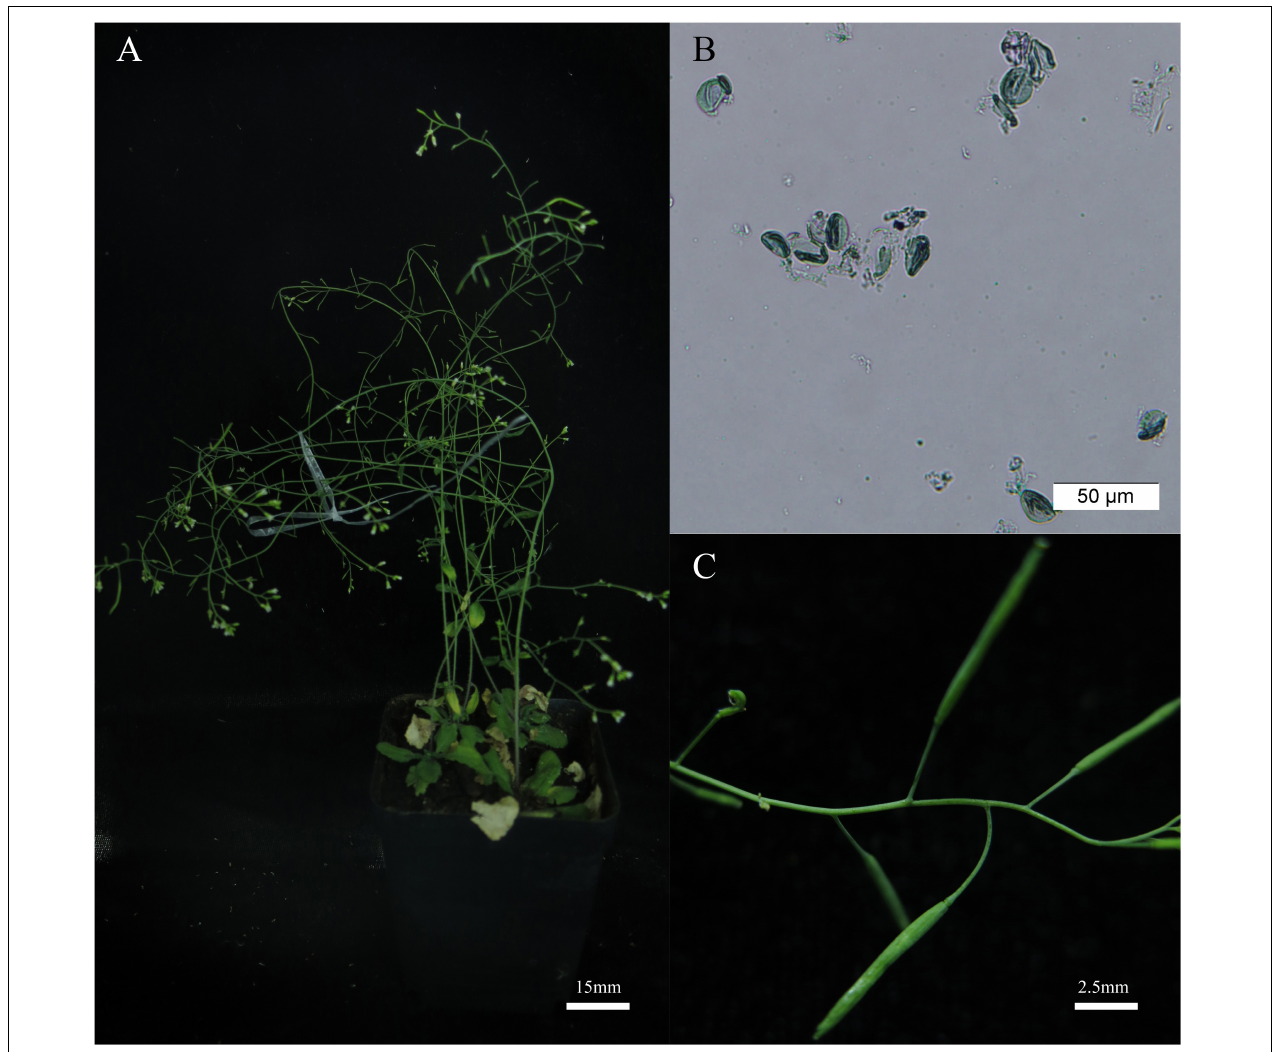
FIGURE 6 | The BnAHAS1 544 T transgenic Arabidopsis plants showed resistance and pistil fertility under 2.00 mg · L − 1 tribenuron-methly (TBM) treatment. (A) Transgenic plants (OE-1-4) treated with 2.00 mg · L − 1 TBM. (B) Pollens viability of the transgenic plants shown in (A) . (C) Pods can be obtained by artificial pollination of transgenic plants after treated with 2.00 mg · L − 1